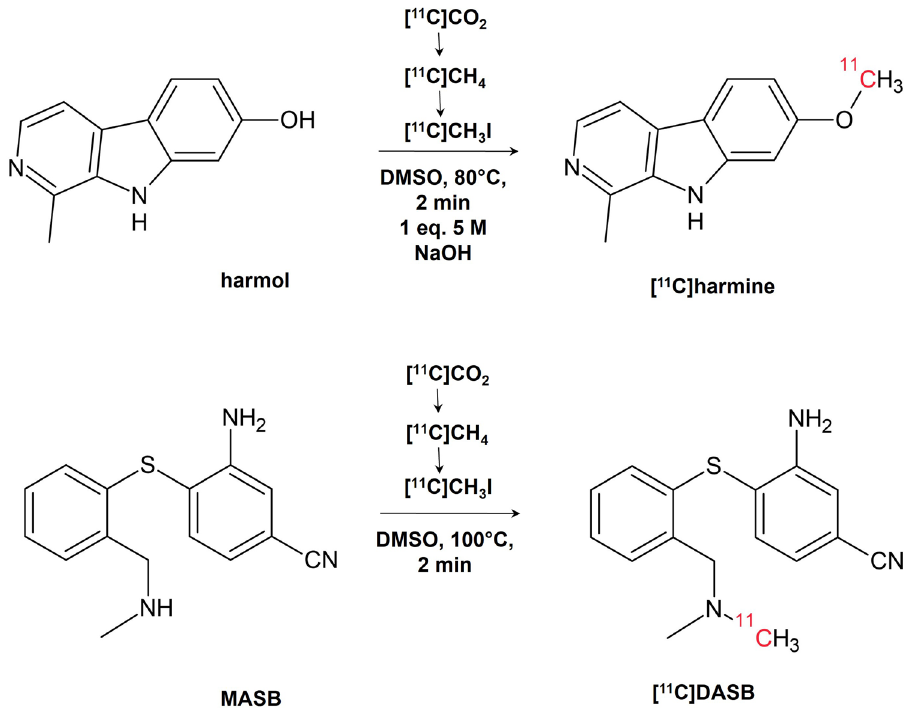
Figure 1. Reaction conditions of the PET brain tracers [ 11 C]harmine and [ 11 C]DASB.